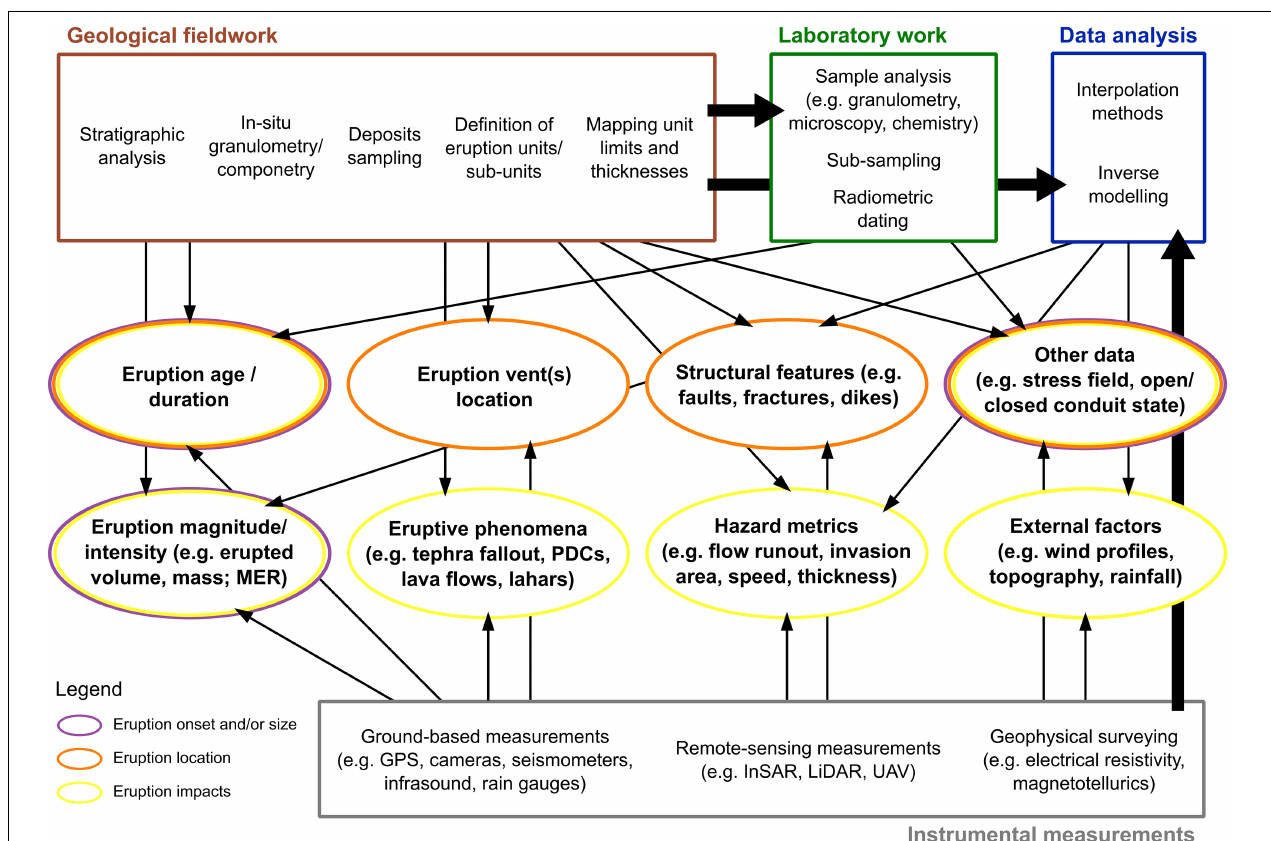
FIGURE 1 | Schematic showing the main types of data (ellipses) that are required to carry out long-term PVHA and some intermediate methods or steps (rectangles) needed to obtain these data. Arrows indicate links between intermediate steps or with derived PVHA data types and variables (ellipses and text within parentheses). Data types are classified according to their use in different components of the hazard assessment: eruption onset and/or size, eruption location and eruption impacts. The majority of the data are generated, directly or indirectly, through geological fieldwork performed on the eruptive products of past volcanic eruptions. Since historical times, direct observations and instrumental measurements of both eruptive parameters as well as external factors (e.g., wind, rainfall, topography) have also become available. MER, Mass Eruption Rate; PDCs, Pyroclastic Density Currents; GPS, Global Positioning System; InSAR, Interferometric Synthetic Aperture Radar; LiDAR, Light Detection And Ranging; UAV, Unmanned Aerial